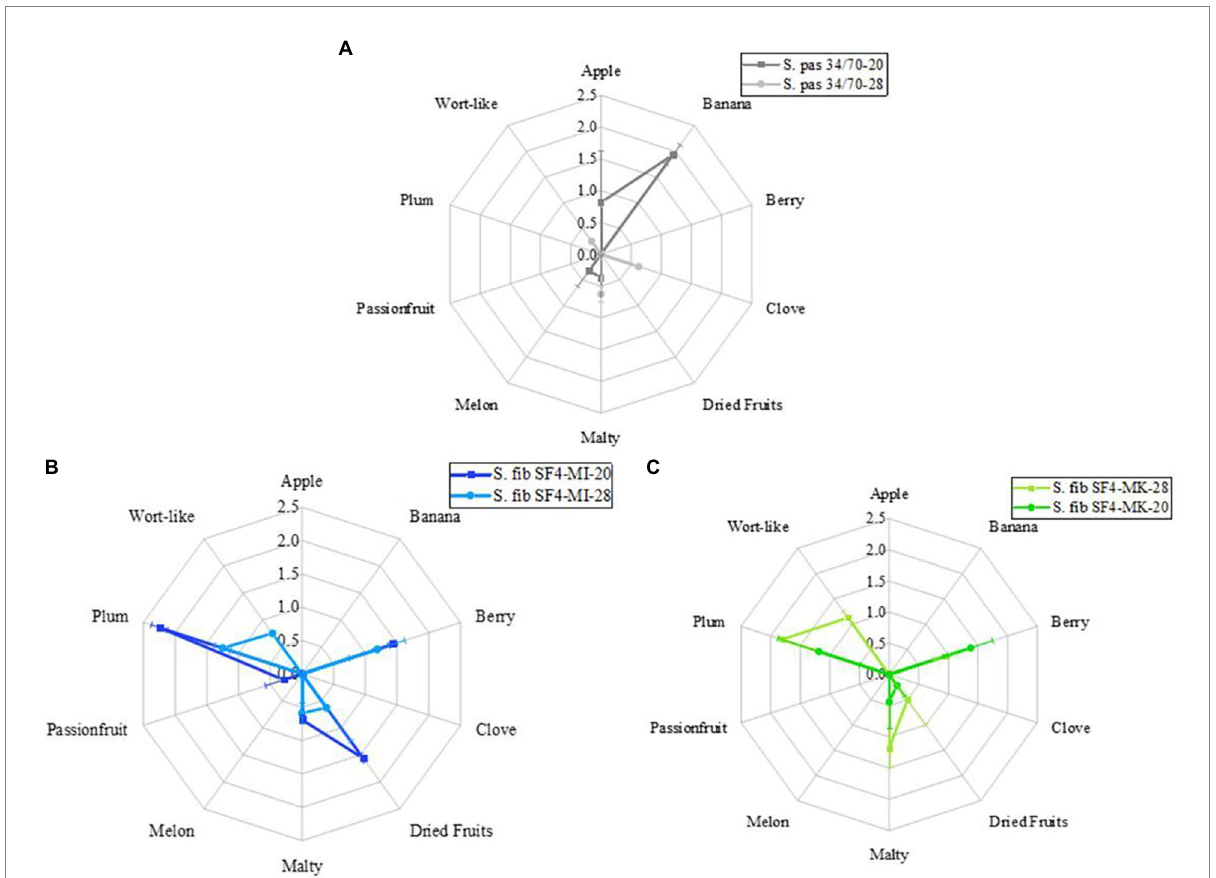
FIGURE 6 Flavor profiles of the beers fermented with the yeast strain S. fibuligera S. fib SF4 as micromanipulated (MI) and mother culture (MK) and the reference yeast strain S. pastorianus S. pas 34/70 at 20 and 28 ° C. Values are shown as means of odor and taste with standard deviations. The number of sensory assessors was n =